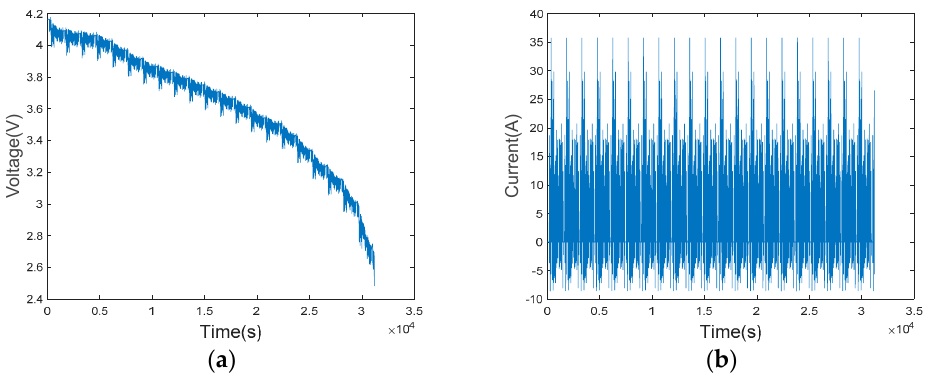
Figure 8. UDDS operating conditions. ( a ) UDDS operating voltage. ( b ) UDDS operating current.